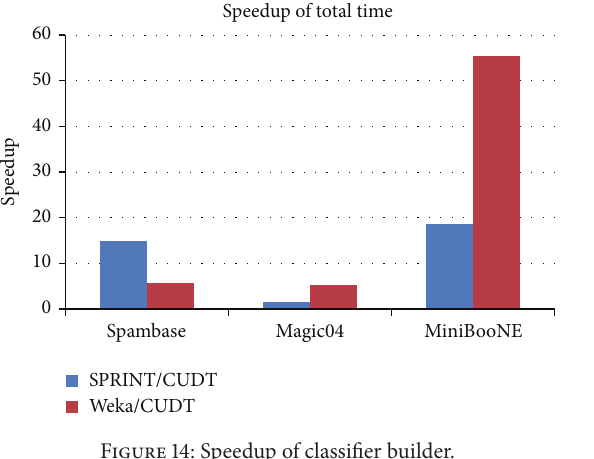
Figure 14: Speedup of classifier builder.